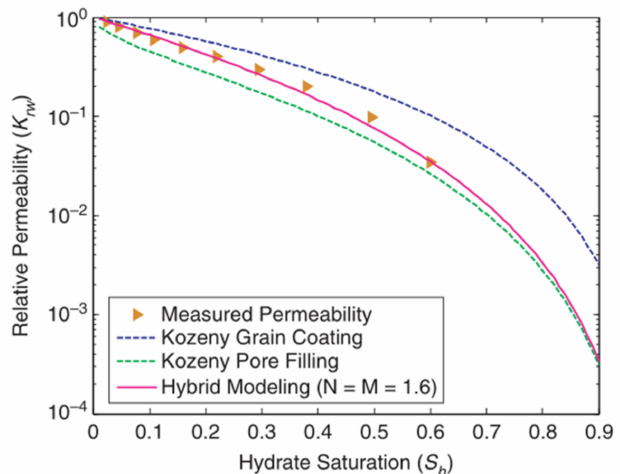
Figure 33. Relative permeability values varying with hydrate saturation from experiment [111] and theoretical models [23,67]. Reprinted with permission from Ref. [67]. Copyright 2013 Society of Petroleum